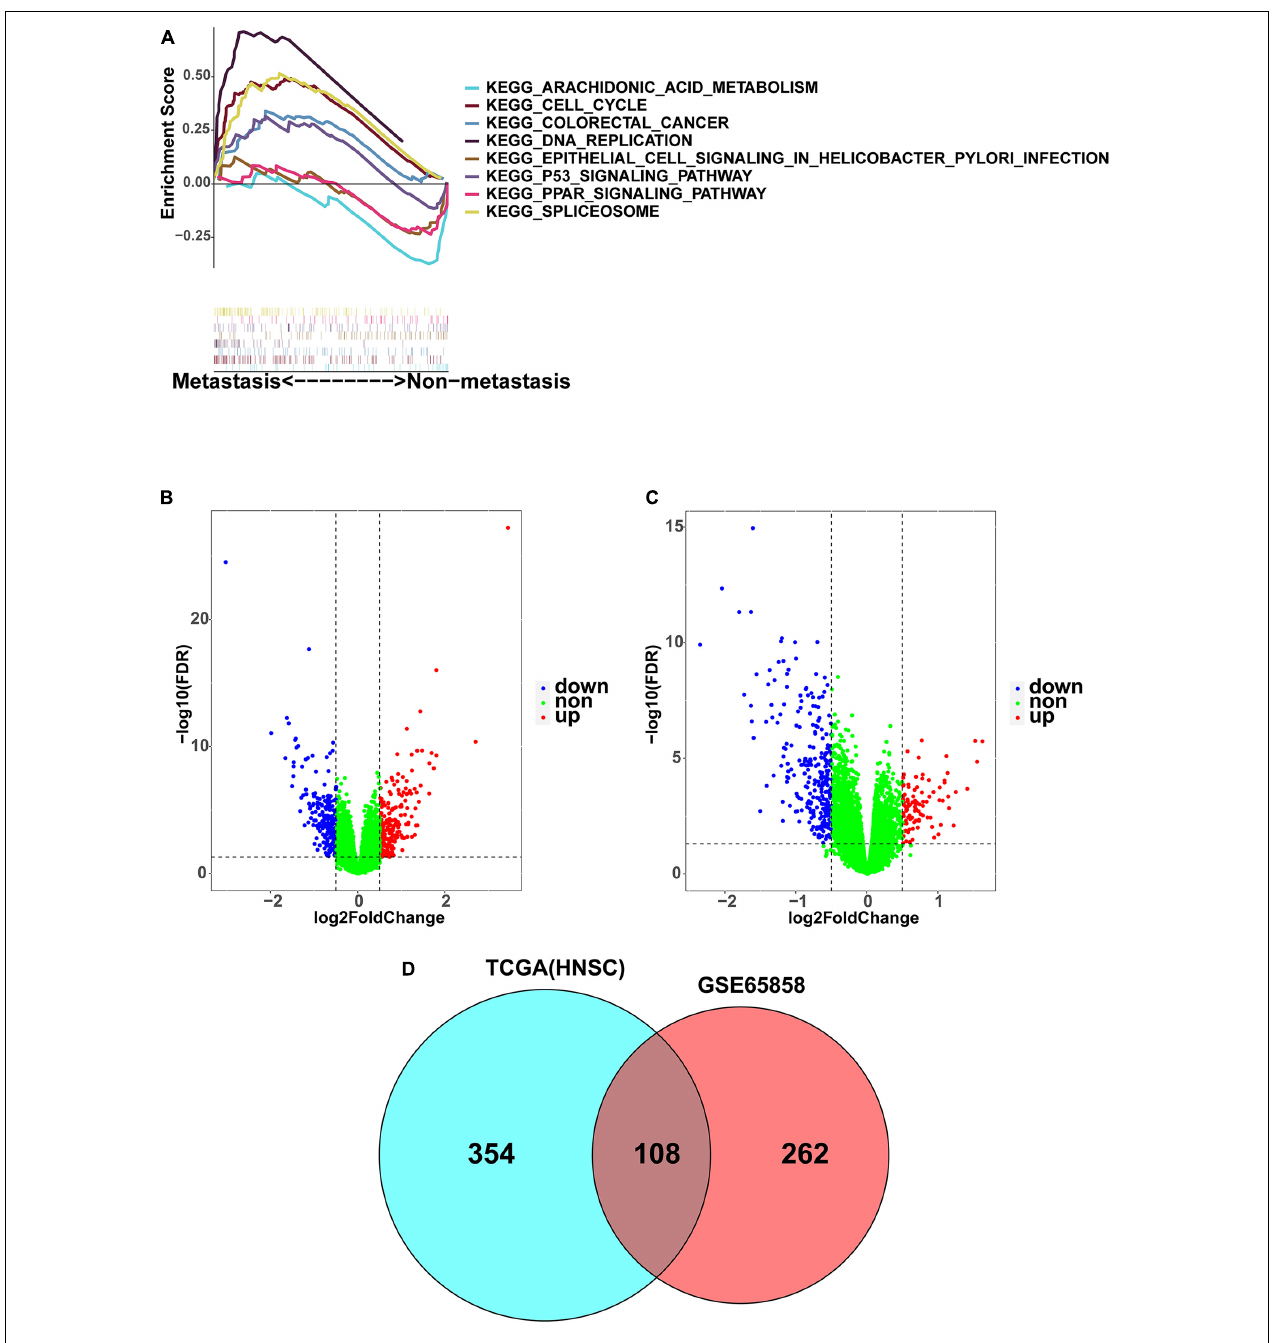
FIGURE 2 | Identification of DEGs associated with HNSCC metastasis. (A) The GSEA enrichment analysis between metastasis group and non-metastasis group. (B) The volcano map presenting the DEGs involved in metastasis in TCGA-HNSC. (C) The volcano map presenting the DEGs involved in metastasis in GSE65858. Blue: downregulated; Red: upregulated. (D) As shown in Venn diagram, there are 108 DEGs shared by GSE65858 (red) and TCGA-HNSC